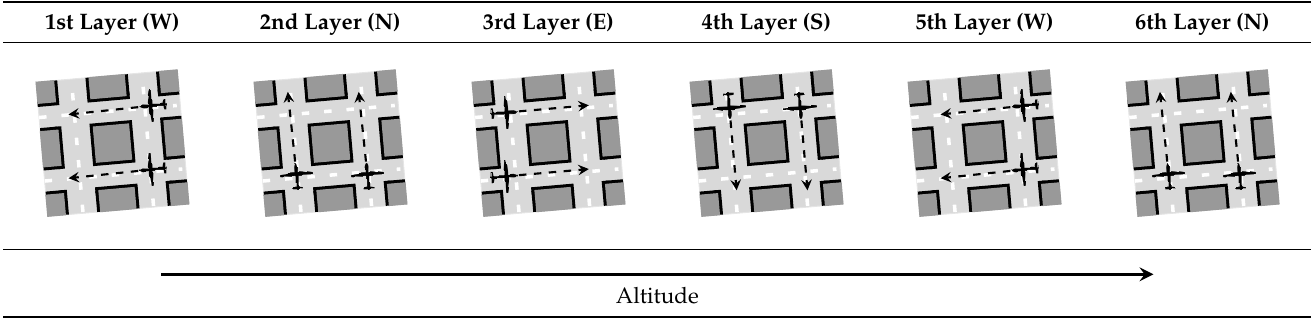
Table 4. Quadrant rules for the baseline airspace structure used for